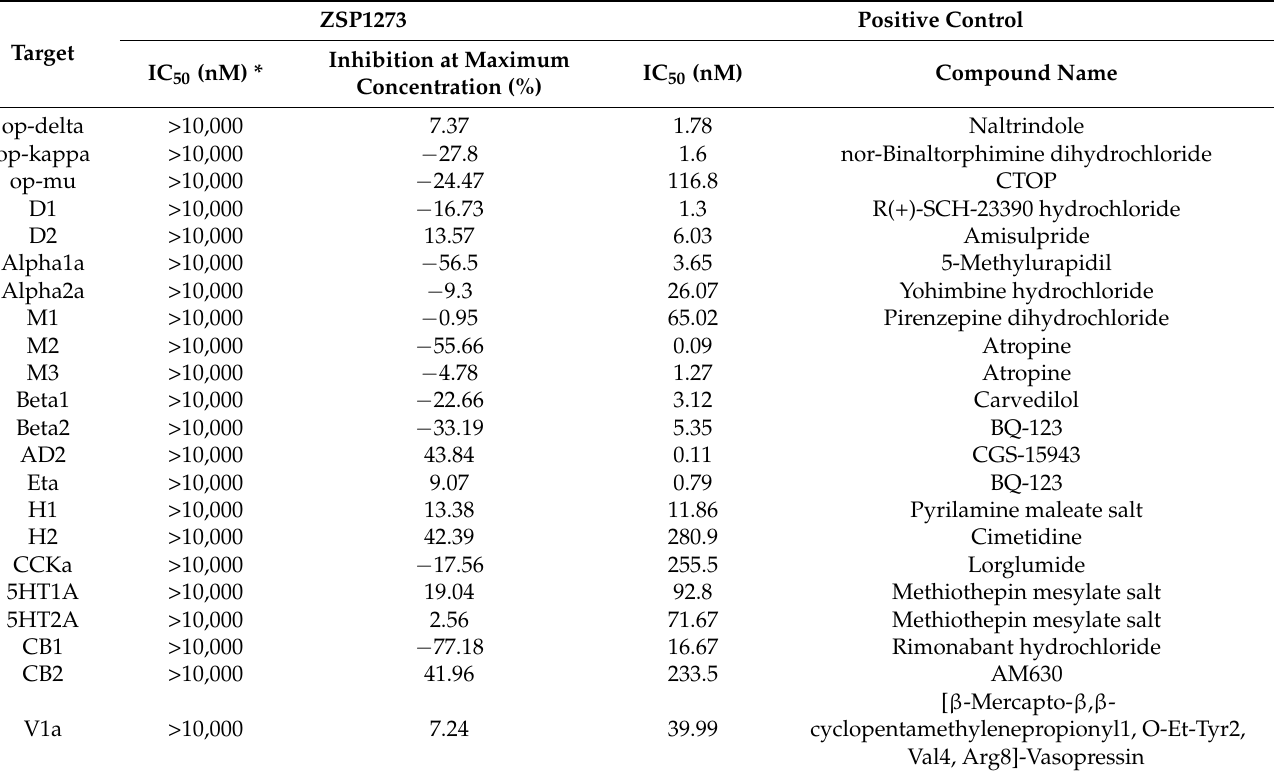
Table A4. Antagonistic effects of ZSP1273 against GPCR targets.